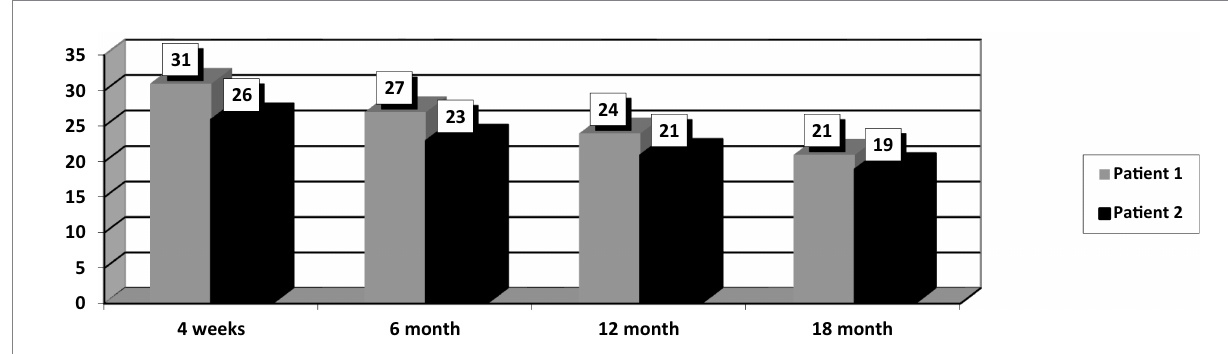
FIGURE 1 Dynamics of PANSS negative subscale values in the course of therapy with